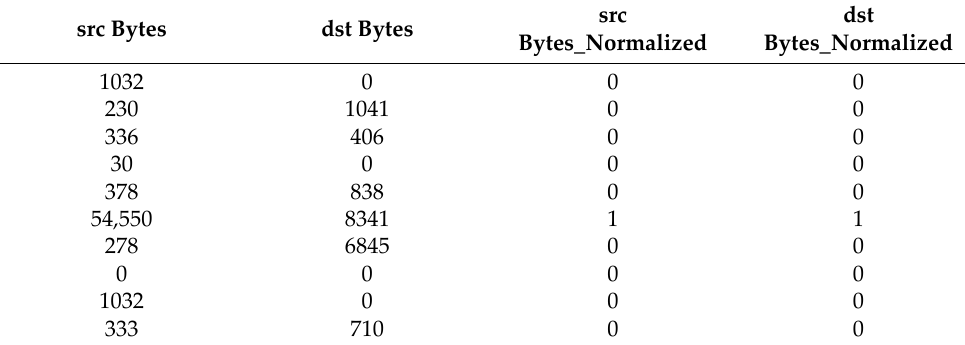
Table 9. Normalization of Numeric Values.